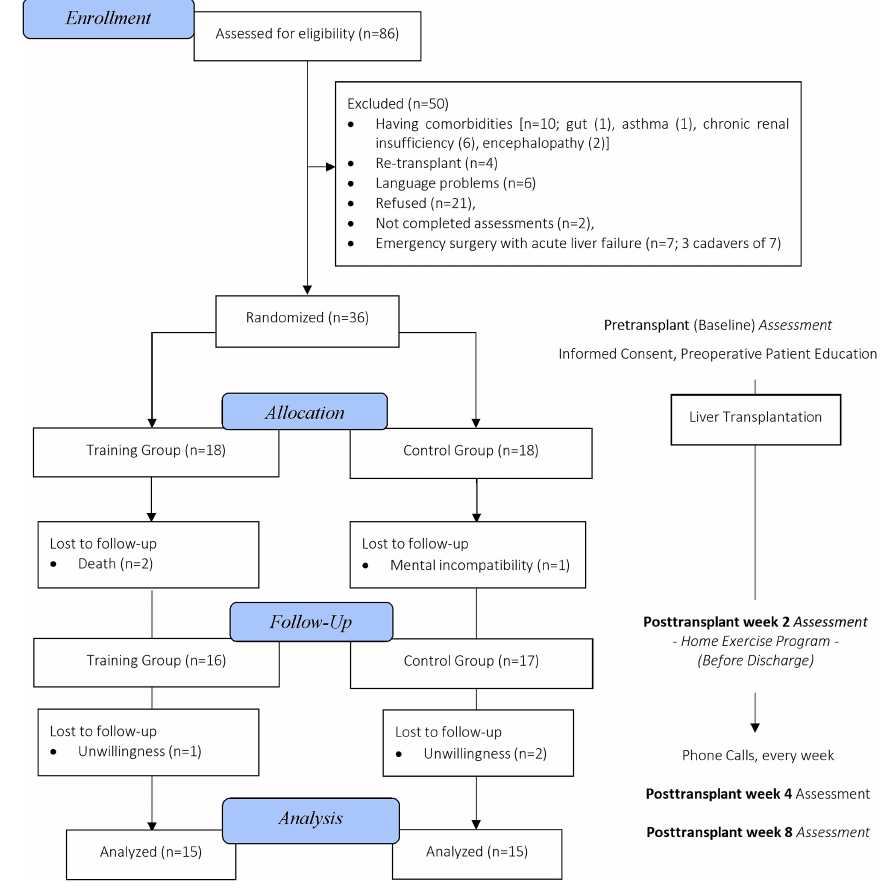
Figure 1. Study flow